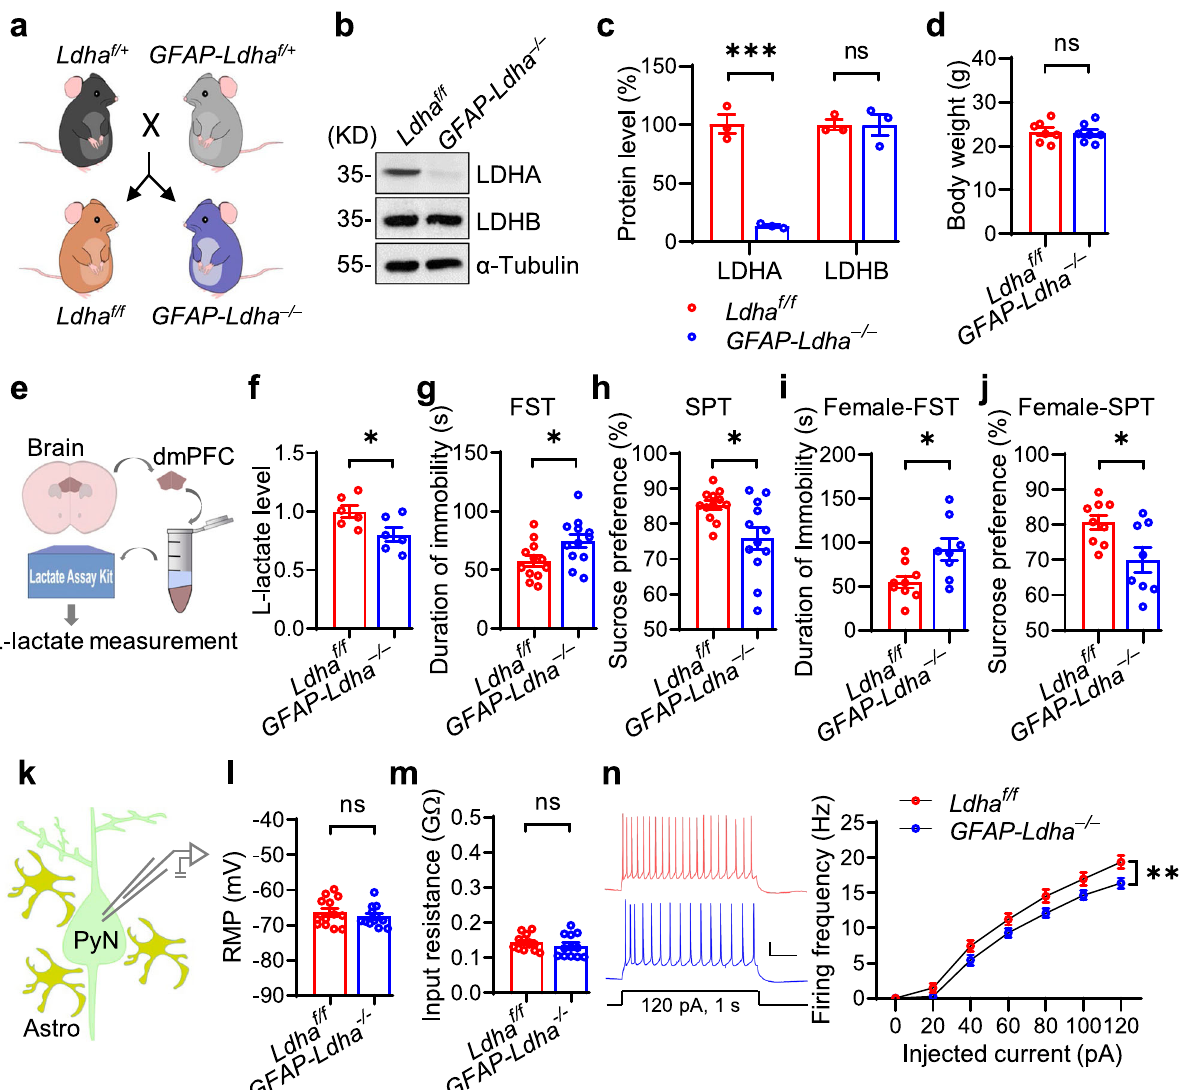
Fig.2| Ldha deletioninthebraincausesdepressive-likebehaviorsandreduces neuronalexcitability.a Breeding strategy. b Representative Westernblotimages. c Quantitative analysis of data in ( b ). n =3 mice per genotype. Student ’ s t -test, for LDHA, t (4) =10.49, p =0.0005; for LDHB, t (4) = 0.0144, p =0.9892. d Similar body- weightbetween Ldha f/f and GFAP-Ldha – / – mice. n =7micepergenotype.Student ’ s t - test, t (12) =0.2446, p =0.8109. e , f Reduced L-lactate levels in the dmPFC of GFAP- p Ldha – / – mice. n =6 mice per genotype. Student ’ s t -test, t (10) =2.435,